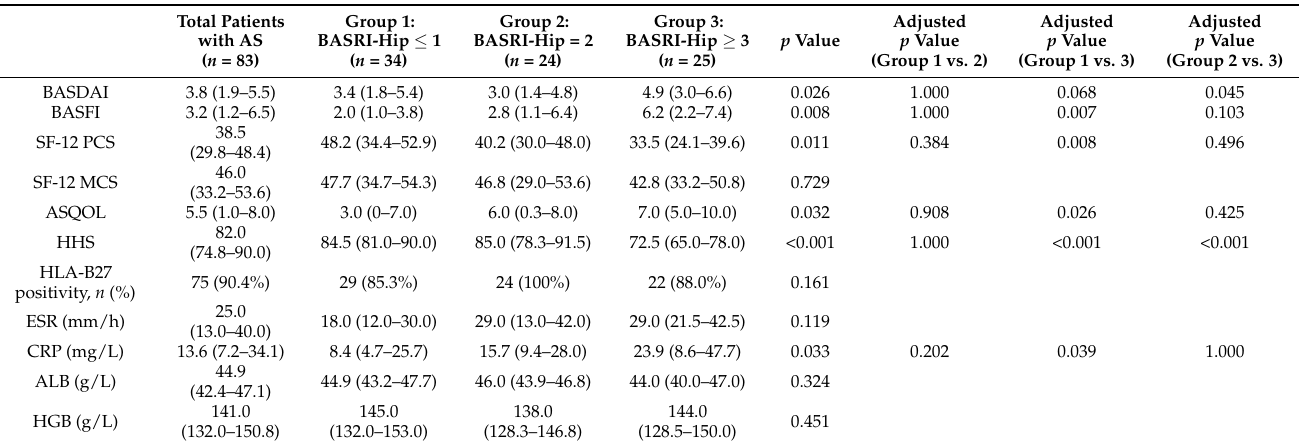
Table 2. Comparison of clinical and laboratory data among patients with ankylosing spondylitis, based on the degree of hip